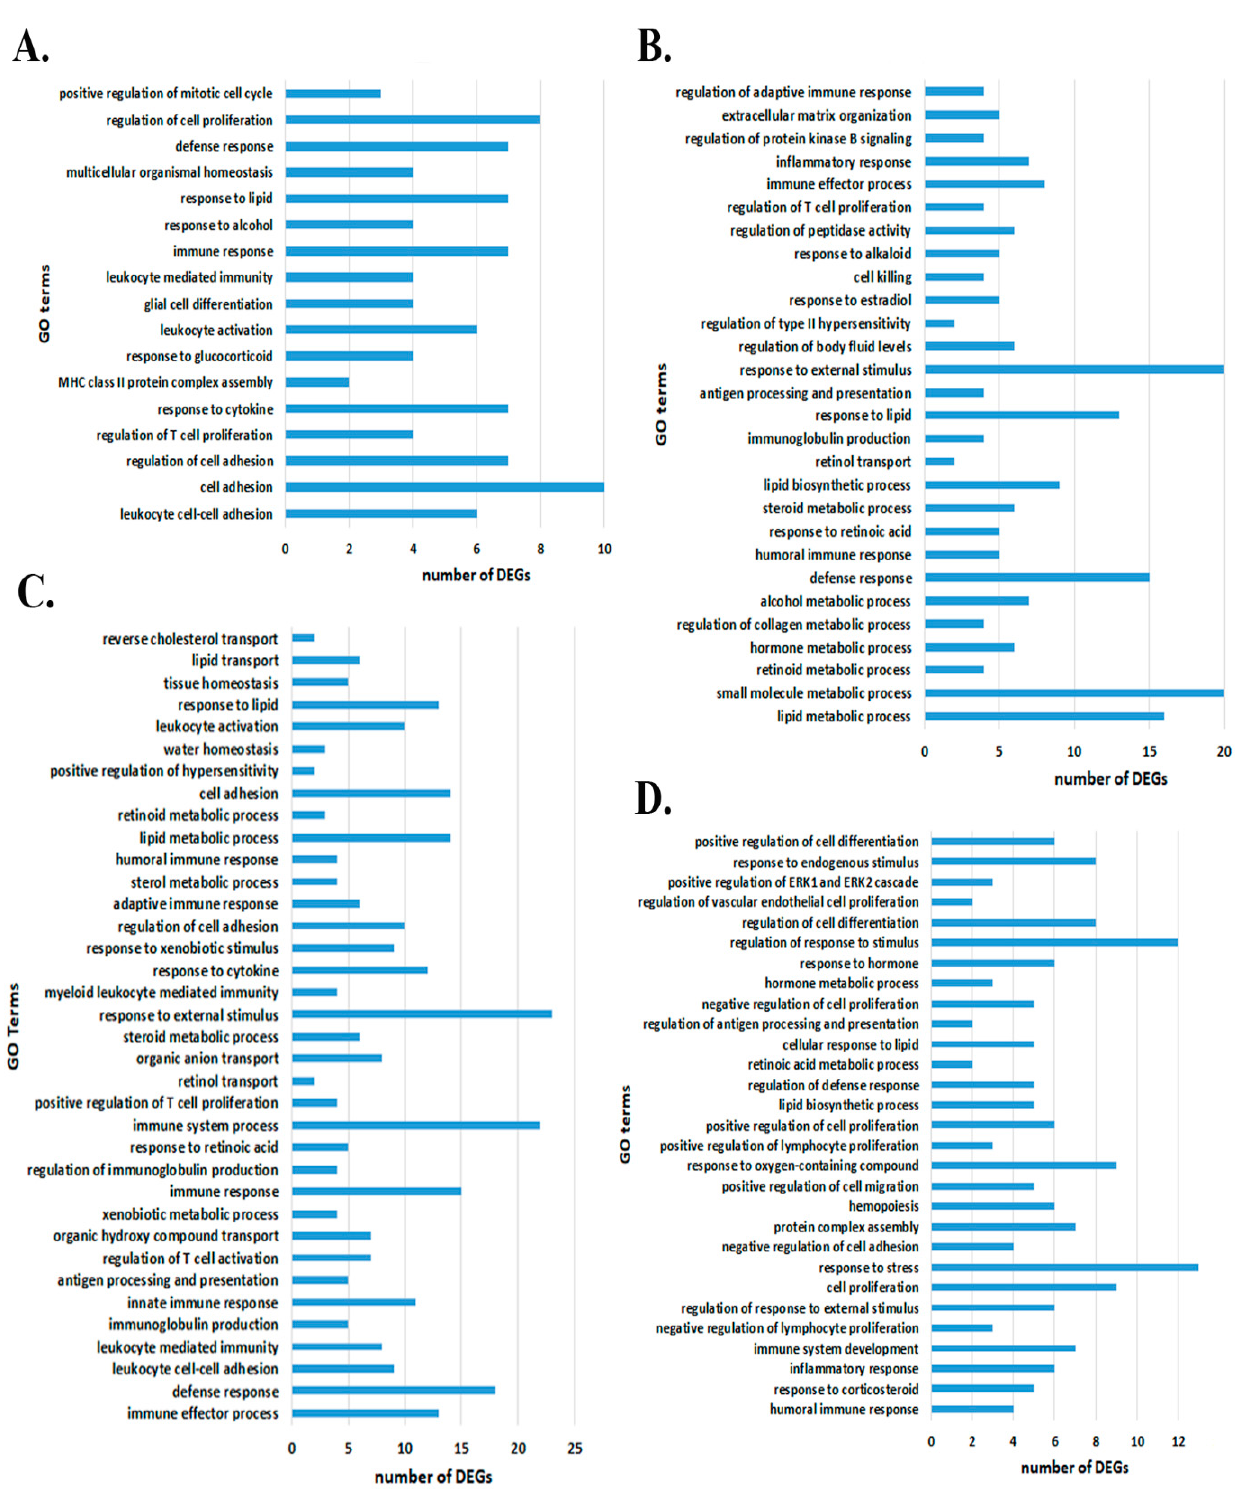
Figure 3. GO terms for DEGs correlating with lncRNAs: ( A ) Snhg4; ( B ) LOC100910237; ( C ) Tnxa-ps1; ( D ) RGD1562890. Significantly ( p < 0.05) enriched biological processes are shown.